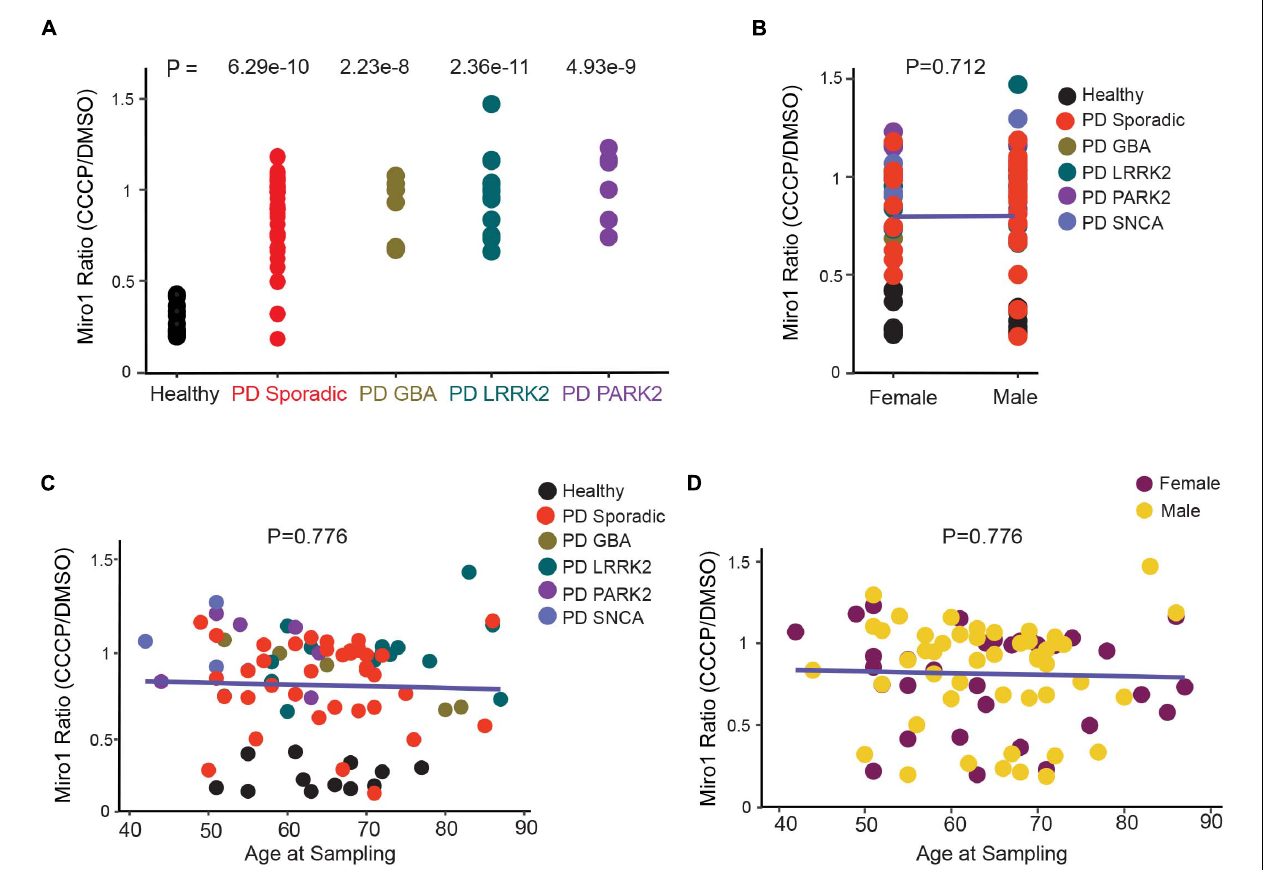
FIGURE 3 | Correlation Analysis of Miro1 Ratio in Fibroblasts. (A) One-Way Anova is used. (B) Two-Way Anova is used to determine the interaction between sex and genetic background with Miro1 ratio as the response variable. (C, D) Multivariable regression is used to determine the interaction between age and genetic background (C) , or age and sex (D) , with Miro1 ratio as the response variable. All P values are calculated by linear